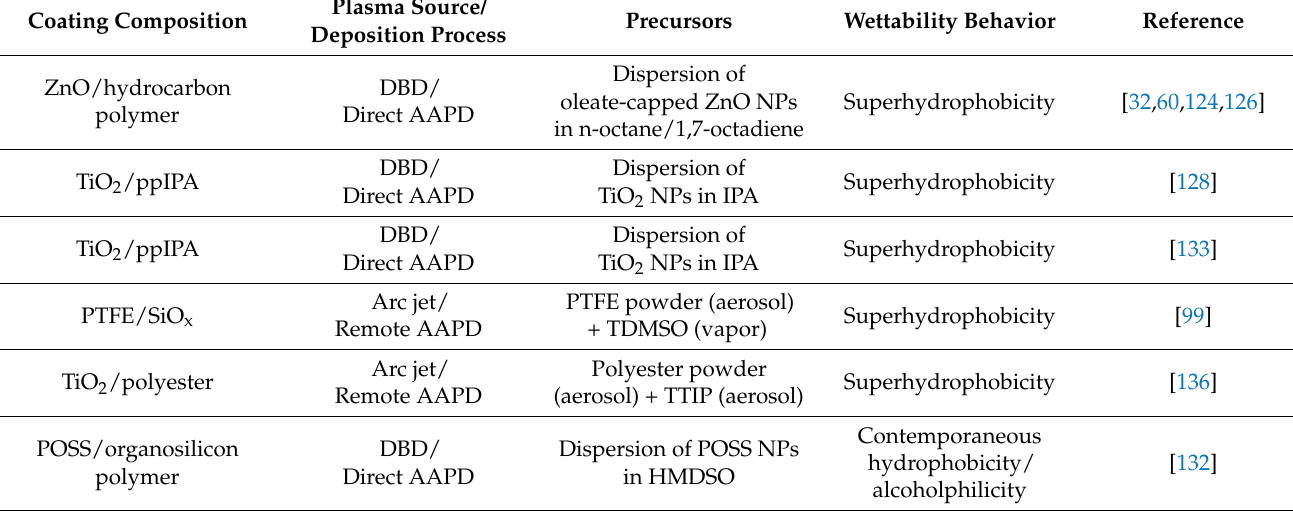
Table 4. Representative studies on APP-deposited NC coatings with superhydrophobic or special wettability properties. Coating